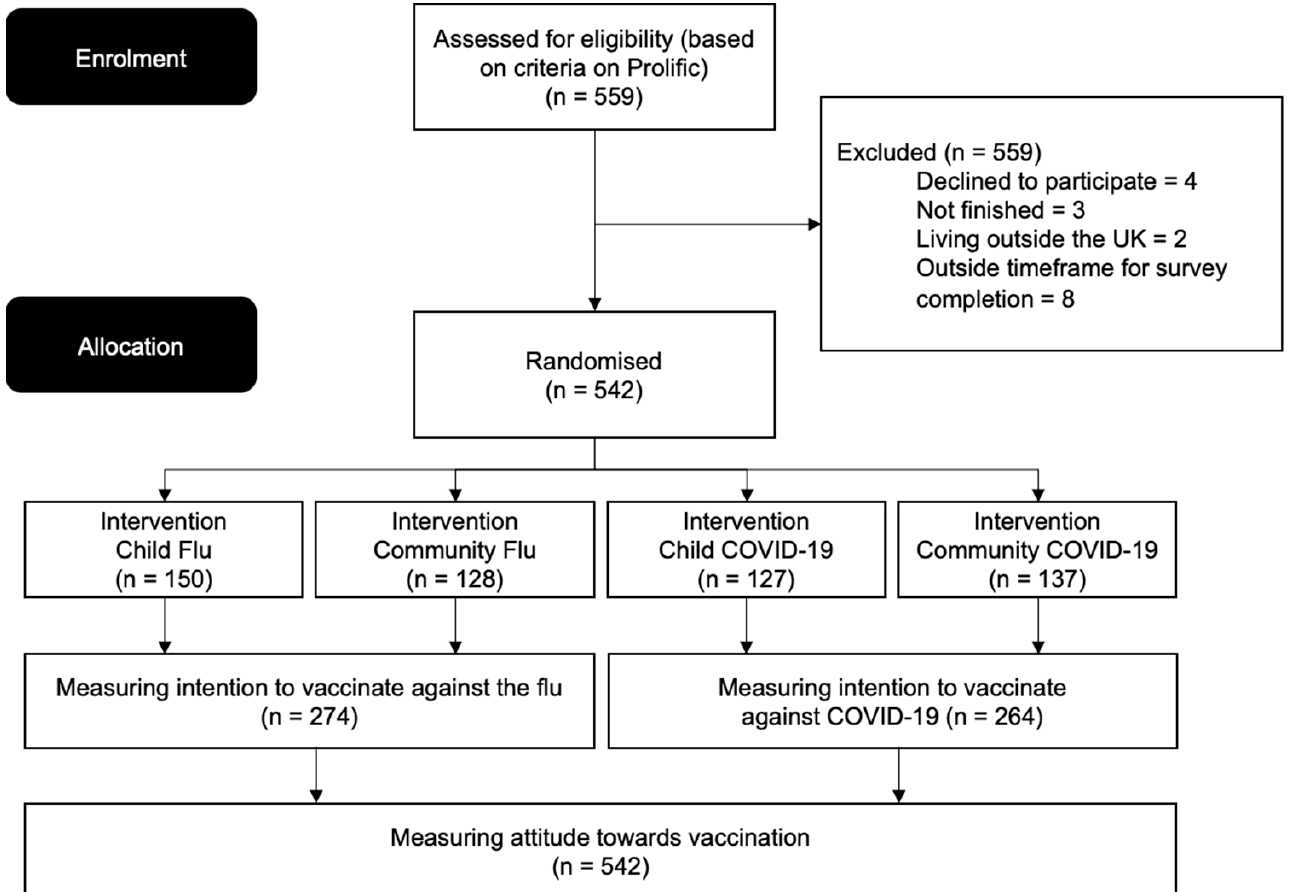
Figure 1. Consort flow diagram of experimental